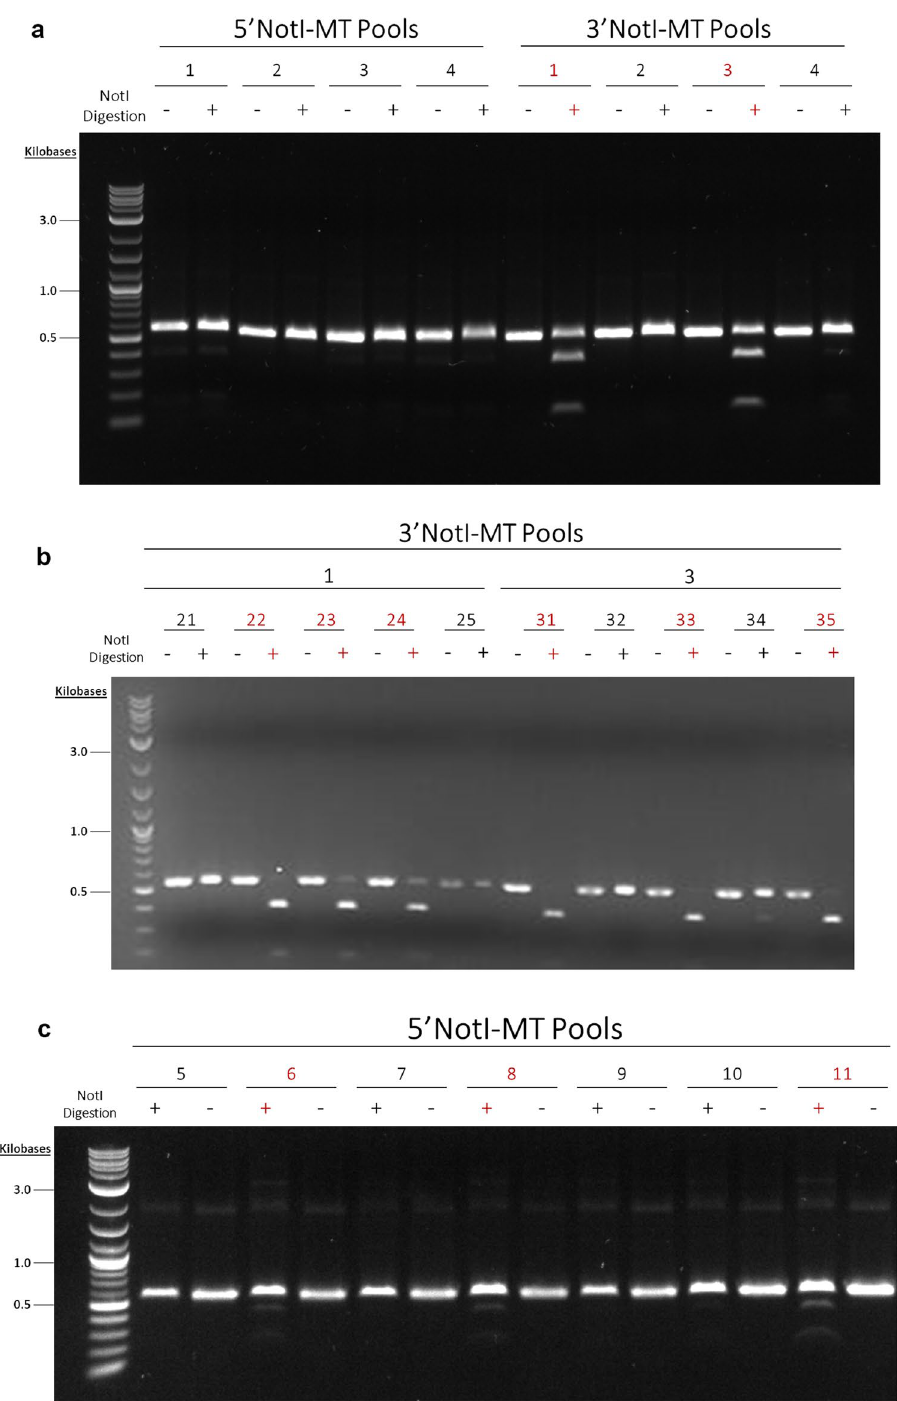
Figure 4. Pooled and single colony NotI digestions of 1364 NotI-MTs. ( a ) NotI digestions were done on four 5 ′ and 3 ′ NotI-MT colony PCR pools consisting of 5 single colonies per pool. ( b ) NotI digestions were done on individual colonies from 3 ′ NotI-MT colony PCR Pools 1 and 3. ( c ) NotI digestions were done on seven additional 5 ′ NotI-MT colony PCR pools consisting of 5 single colonies per pool. Pools containing uncorrected NotI-MT DNA can be seen in lanes containing intact, undigested linear PCR amplicons as single bands. Pools containing corrected NotI-MT DNA can be seen in lanes with multiple bands after amplicon digestion are shown in red, with the upmost showing uncut, uncorrected PCR amplicon and the lower two showing successful NotI digested fragments. Original gels are presented in Supplementary Fig.